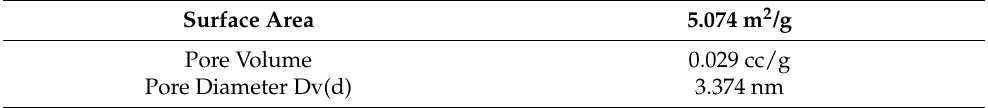
Table 2. Parameters for synthesized